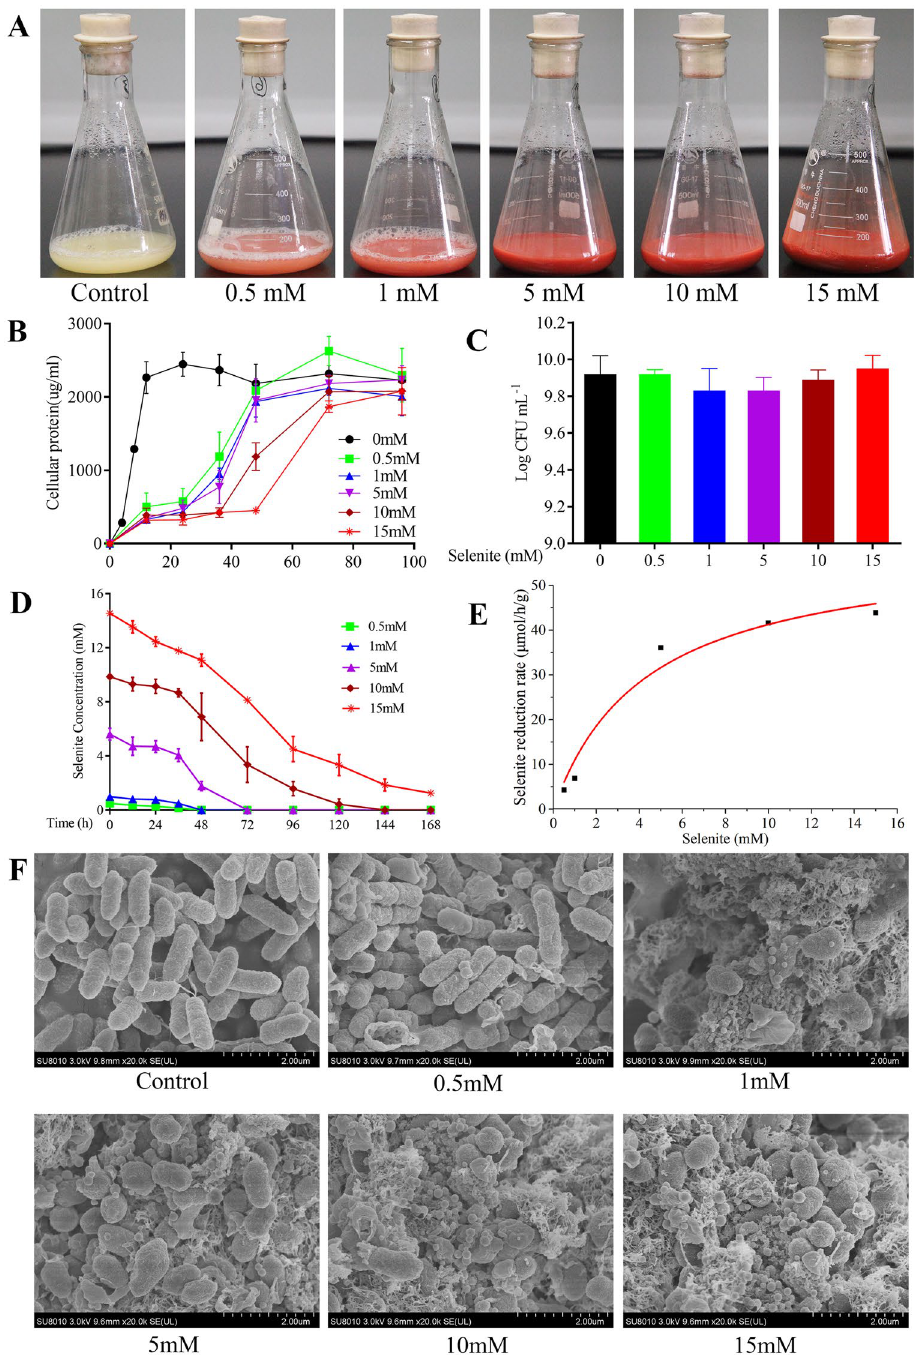
Figure 1. Growth and selenite reduction of E. cloacae Z0206 in the presence of various concentrations of selenite. ( A ) Apparent changes in spent broth. ( B ) Growth profile under different selenite concentrations. Samples of 1 ml of the bacterial culture were collected at different time intervals of bacteria growth and then centrifuged at 4 °C and 10,000 × g for 10 min. Protein was extracted from the pellet using a total bacterial protein extraction assay kit. Bacterial growth was measured via the quantification of total cell protein. The protein concentration in bacteria cell extracts was determined. ( C ) Quantity of bacteria at the time point of 96 h. ( D ) Dynamic changes in selenite residue in the broth. ( E ) Kinetic study of selenite reduction by E. cloacae Z0206 under different selenite concentrations. Line graphs and bar graphs are presented as the mean ± SD, ** P < 0.01 (n = 3). ( F ) SEM analysis of E. cloacae Z0206 under different selenite concentrations. The bacteria were cultured in the presence of various concentrations of selenite (0 mM, 0.5 mM, 1 mM, 5 mM, 10 mM and 15 mM). Samples were collected when the selenite was completely consumed according to the results in Fig.